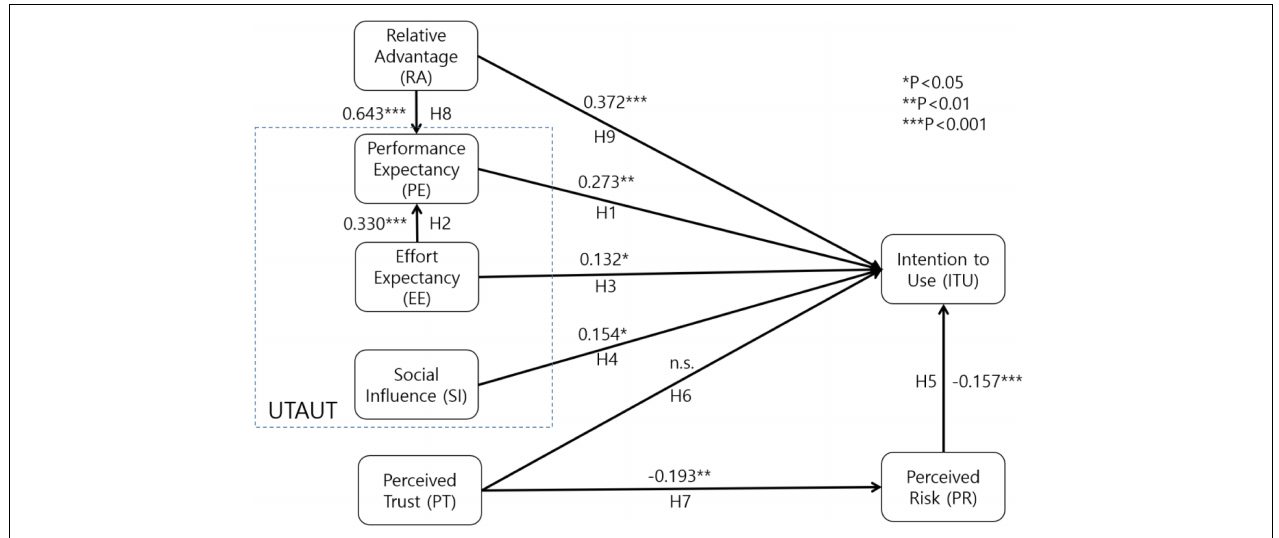
FIGURE 1 | Hypothesized